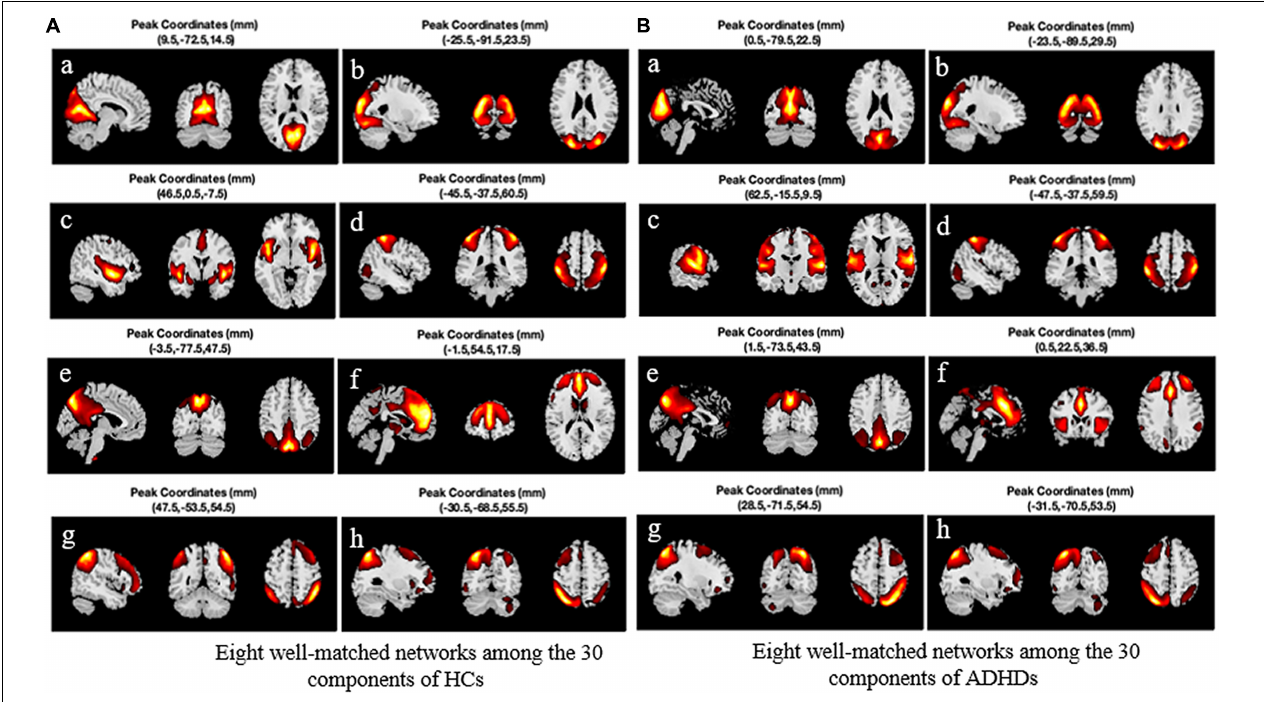
FIGURE 3 | Eight best-matched intrinsic connectivity networks (ICNs) and their peak activation coordinates. (A) The eight best networks among the 30 components extracted from HC. (B) The eight best networks among the 29 components extracted from ADHD. HC, healthy control; ADHD, attention deficit hyperactivity